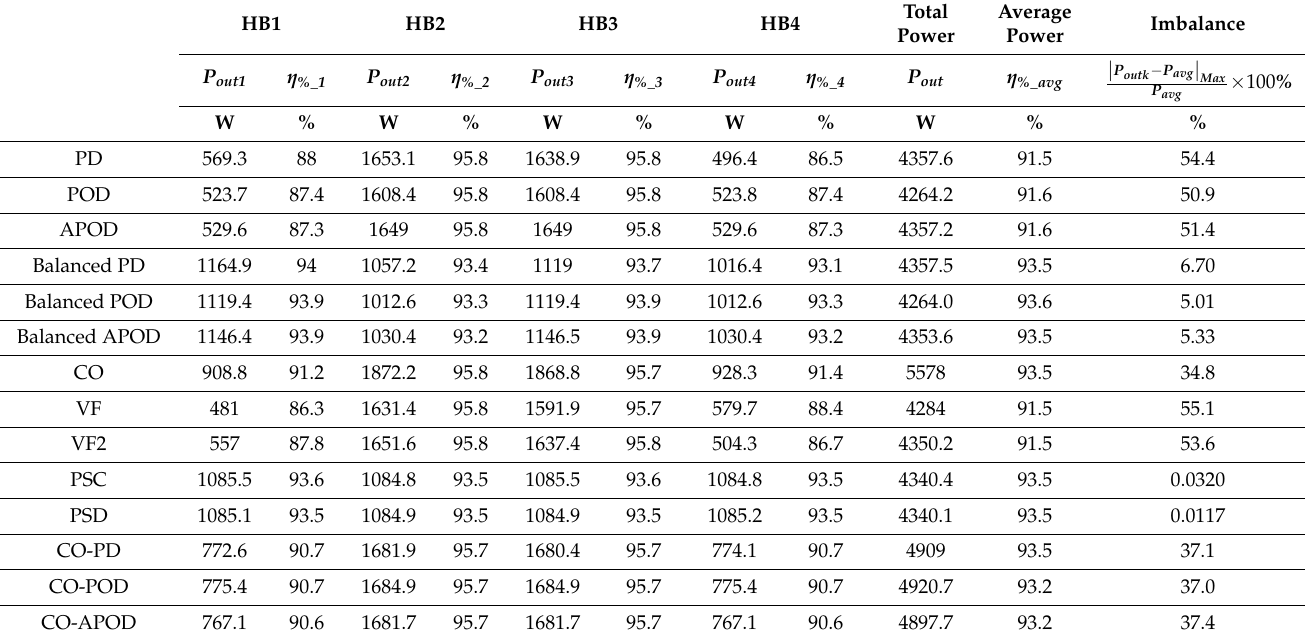
Table 6. Comparative output power and efficiency on each submodule and total power